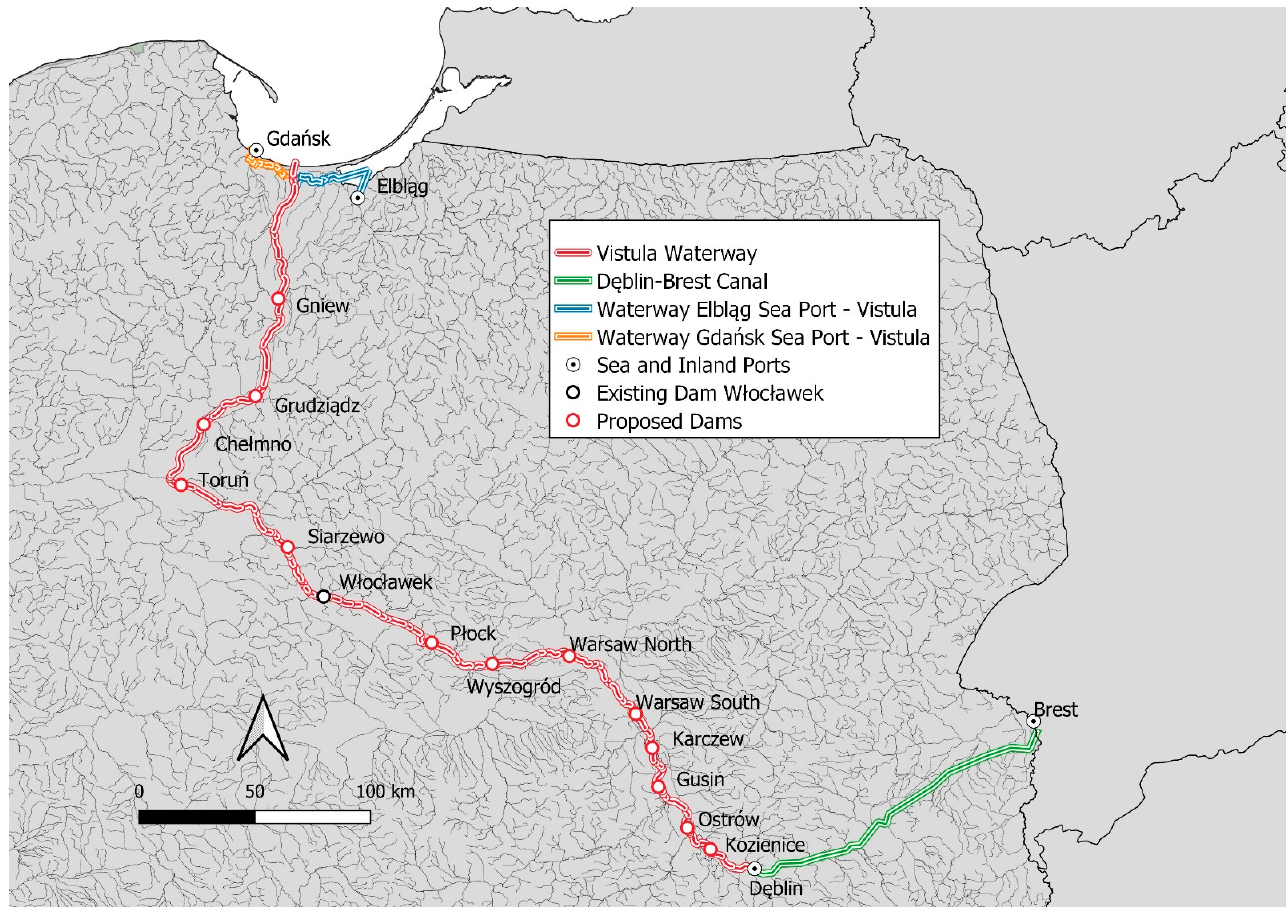
Figure 1. The waterway route according to alternative number 2 with the location of the existing (W ł oc ł awek) and proposed dams on the Vistula River [48].